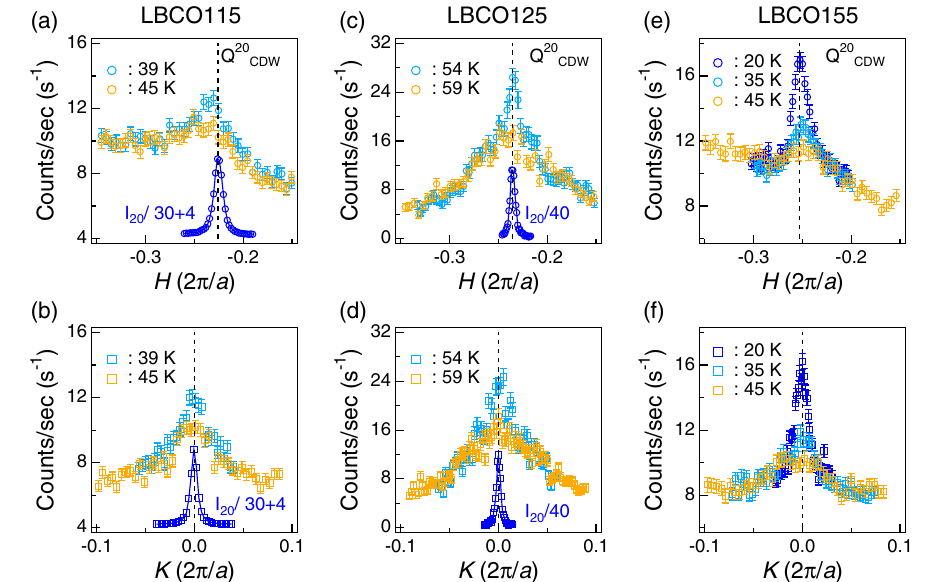
FIG. 3. The doping-dependent evolution of the two-stage CDW. (a) and (b) show the integrated RIXS intensity ( (cid:2) 100 meV with respect to the elastic line) of LBCO115 along the H and K directions, respectively. The same plots of LBCO125 and LBCO155 are shown in (c),(d) and (e),(f), respectively. Blue symbols represent data at 20 K. Because of the large LCDW signal in LBCO115 and LBCO125, the 20 K intensity I 20 is normalized and offset to I 20 = 3 þ 4 and I 20 = 4 for LBCO115 and LBCO125, respectively. The cyan (yellow) symbols represent the data just below (just above) the critical temperature, where the LCDW starts to emerge. Dashed lines represent Q at 20 CDW